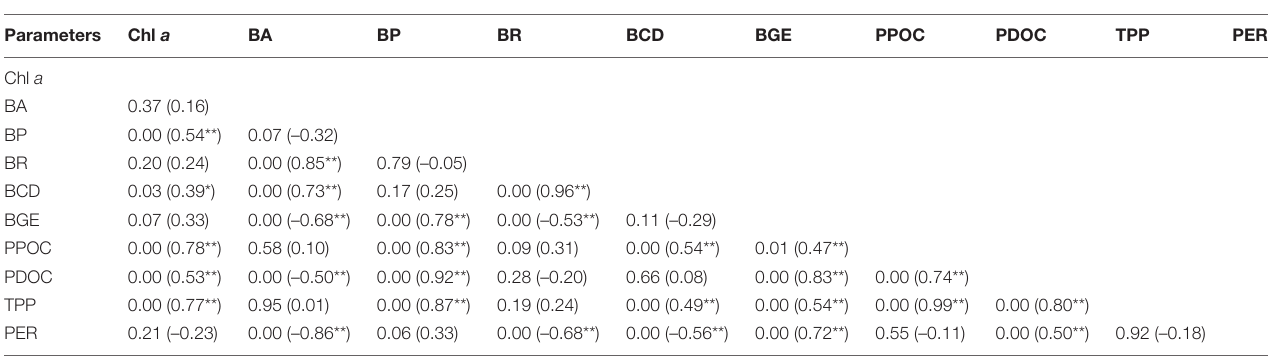
TABLE 4 | Pearson correlation coefficients between biological and non-biological parameters.